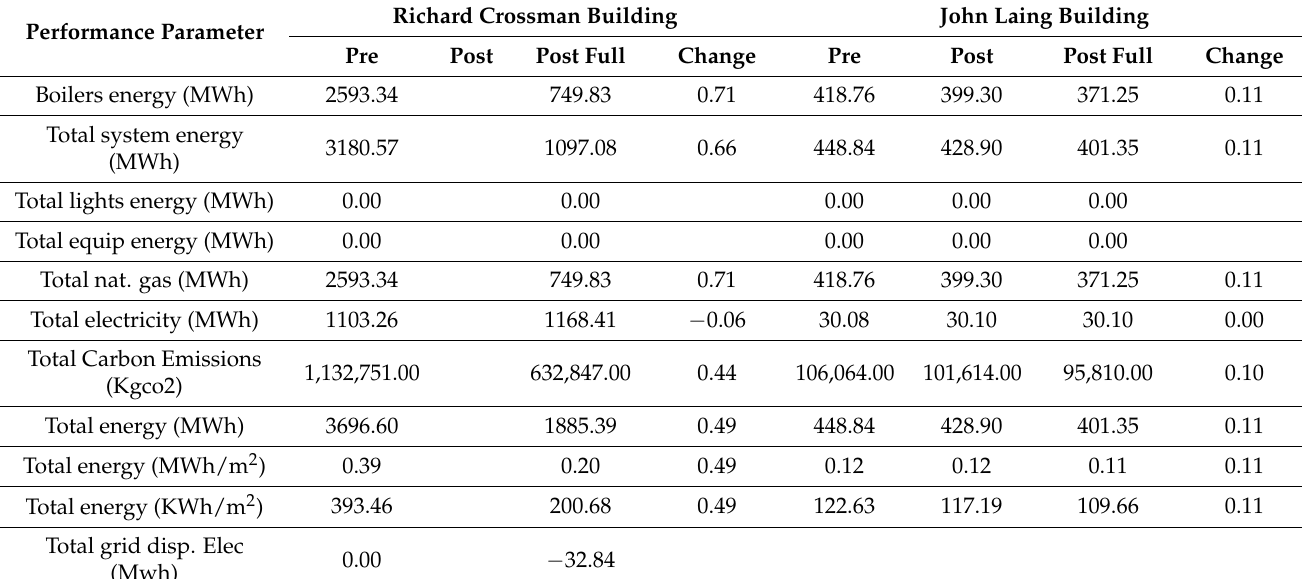
Table 11. Energy performance result of both